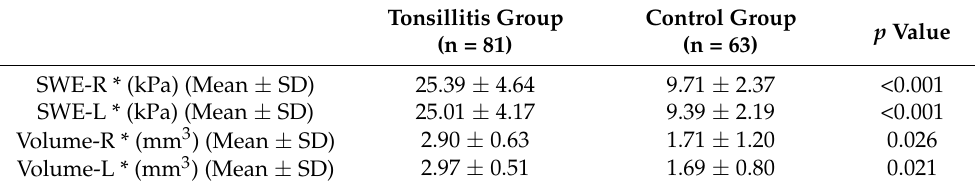
Table 2. Data in the tonsillitis and healthy control groups, and comparison between groups.